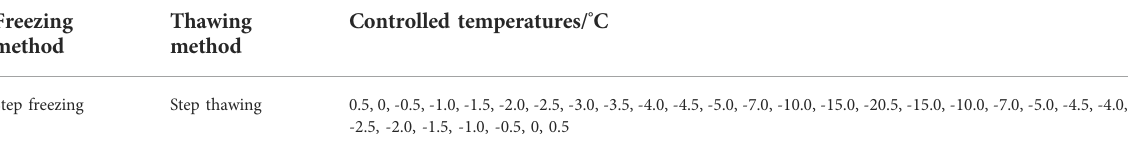
TABLE 2 Freezing/thawing method and controlled